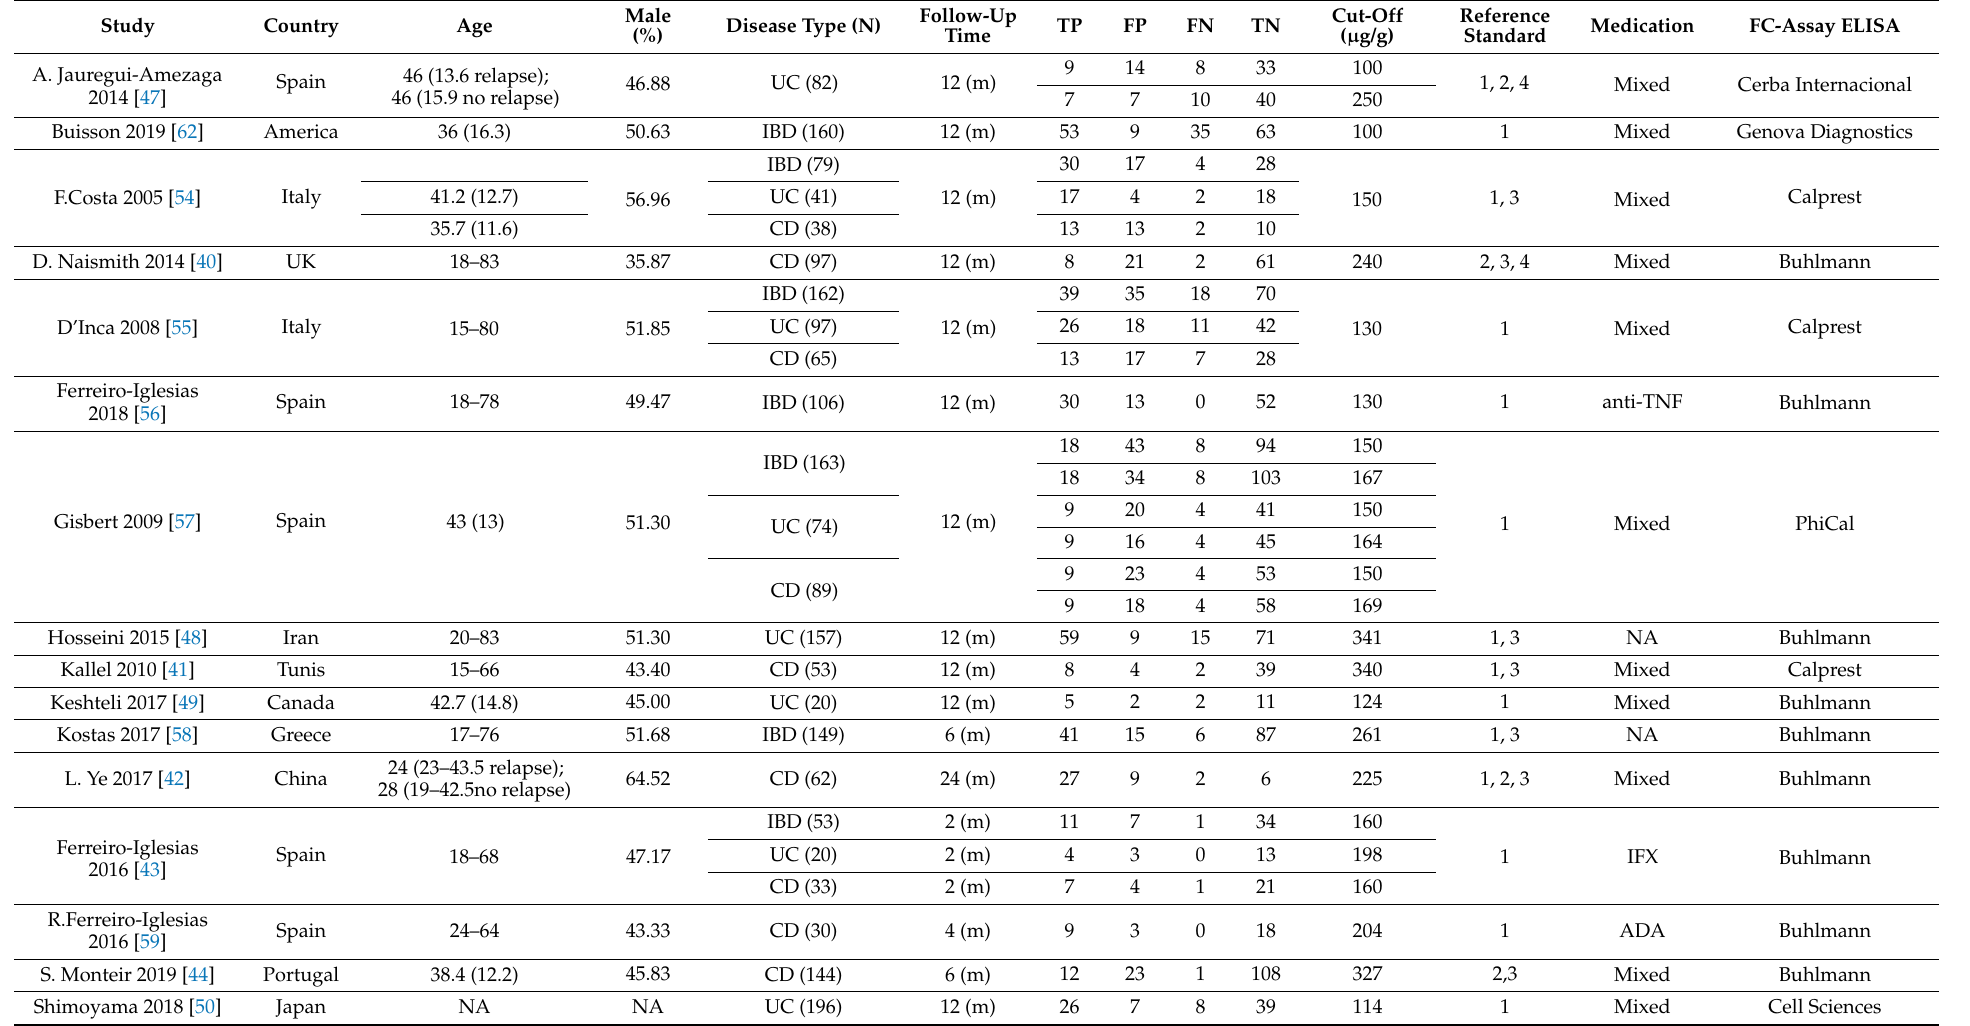
Table 2. Summary of findings and raw data of studies included in the